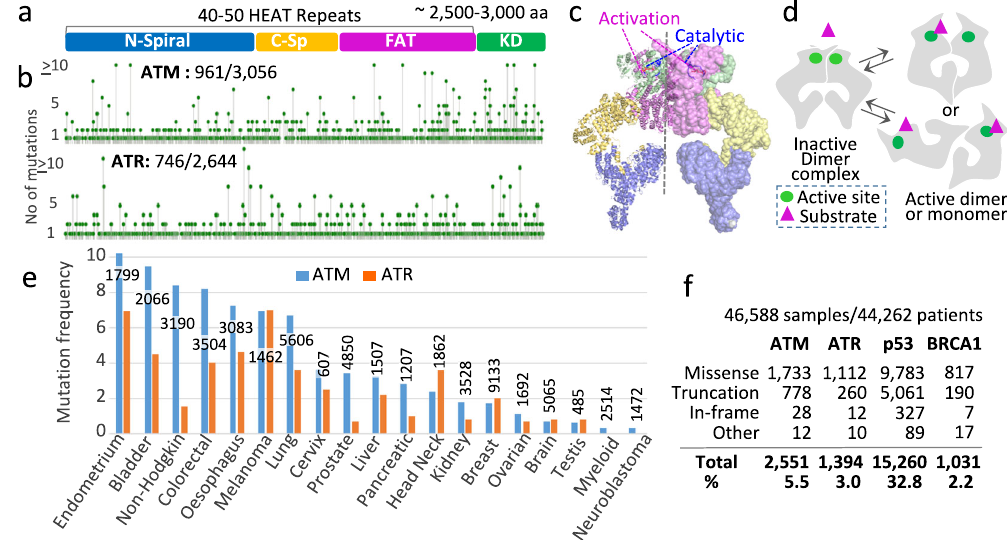
Fig. 1 ATM/ATR mutations in human cancer. a ATM/ATR proteins are large (~2200 – 3000 residues) and comprise 40 – 50 tandem HEAT repeats followed by a highly conserved kinase domain 45 . The HEAT repeat domain is divided into three conserved structural motifs referred to as the N-spiral/ solenoid, C-spiral/bridge/pincer, and FAT domains 9 – 12 . b Screen shot images from the cBio Cancer Genomics Portal website (http://cbioportal.org). The images show the location and frequencies of ATM/ATR residues mutated in 46,588 tumor samples in the database. In ATM, 961 of the 3056 residues are mutated; in ATR, 746 of the 2644 residues are mutated (Supplementary Data 1 and 2). c A cryo-EM model structure of the ATM enzyme complex (PDB 5NPO, 5.70 Å) 9 . The complex is a dimer comprising two identical protomers that share multiple interfaces. The protomer on the right and left are in surface and cartoon representations, respectively. Both protomers are shown in four colors, each corresponding to the indicated domain in a . The catalytic and activation loops in the active site are shown in red and blue, respectively. d Model: the ATM/ATR and Tel1/Mec1 enzyme complexes are in dynamic equilibrium between an inactive and active conformations. Under unchallenged conditions the dimeric complex exists as a minimally active enzyme, in which substrate accessibility to the active site is sterically hindered. Stress-dependent conformational change activates the enzyme by relieving the block. The activation may take place in the dimer context or entail a dimer-to-monomer transition 9 – 12,46 . e ATM/ATR mutation frequencies in the indicated cancer types (Supplementary Table 1; http://cbioportal.org). The number of tumor samples analyzed for each cancer type is as indicated. f The number of cancer-associated missense, truncation, in-frame, or other mutations in ATM , ATR , P53 , or BRCA1